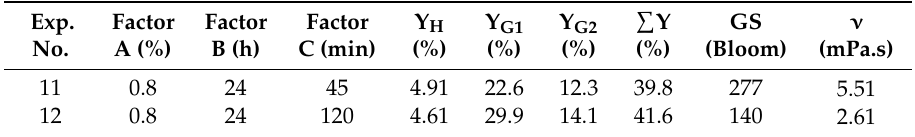
Table 2. Design of the optimization experiments and results of characterization of the process, the gel strength, and the viscosity of prepared